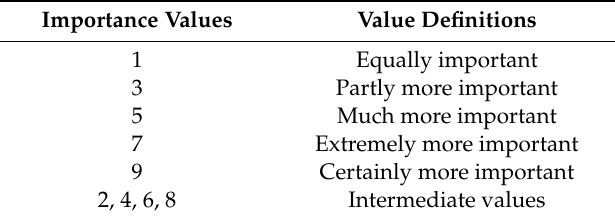
Table 1. Saaty’s priority scale